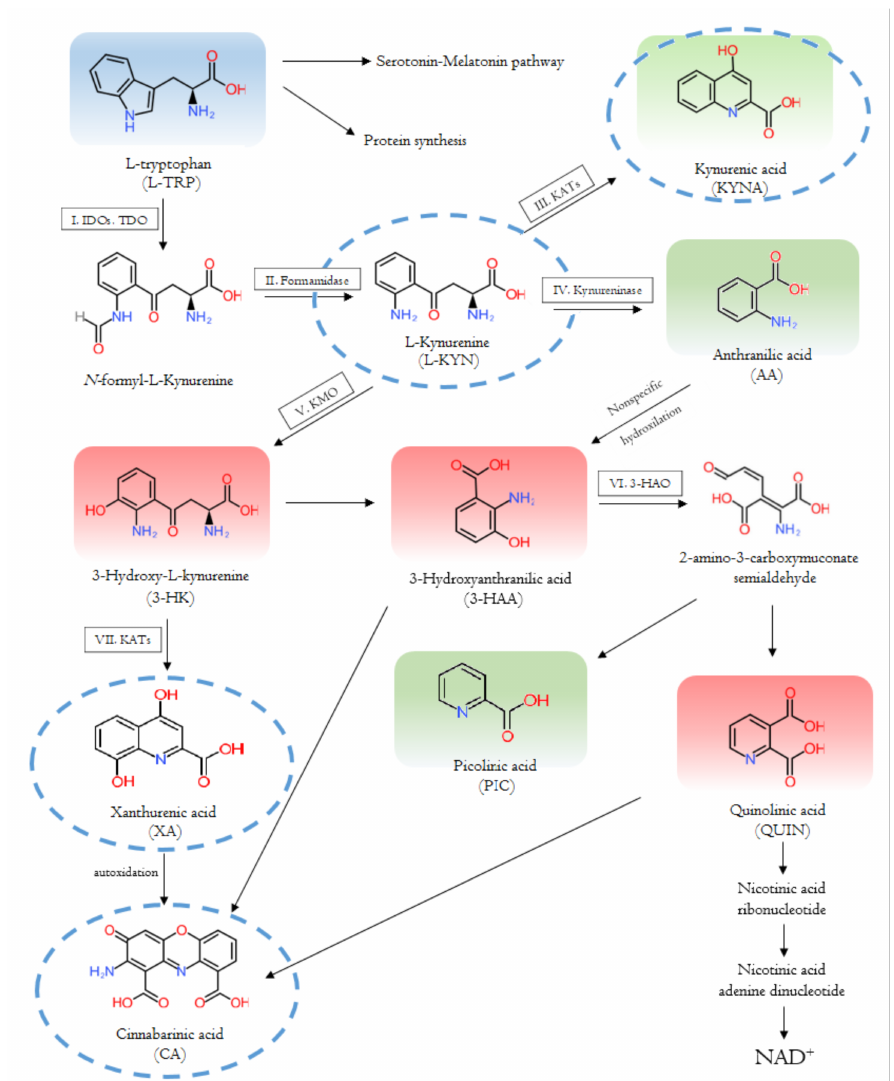
Figure 2. The tryptophan-kynurenine metabolic pathway and bioactive kynurenine metabolites. The pathway depends on the type of cells. In some cells some enzyme is missing, and thus, some metabolite is not produced. The kynurenine metabolites are multifarious molecules with various properties. The aryl hydrocarbon receptor (AhR) ligands are circled with a blue dotted line; toxic kynurenines (KYNs) are in red shade, and protective KYNs are in green shade